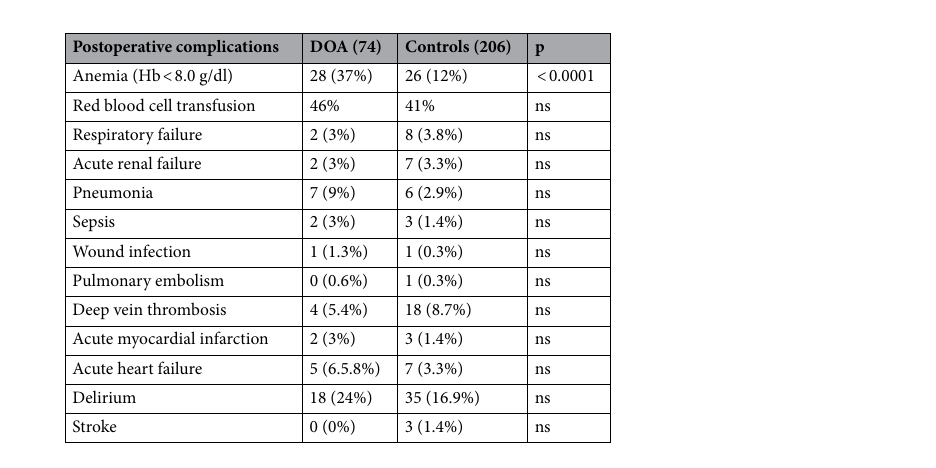
Table 4. Comparison of postoperative complications between patients taking anticoagulants and